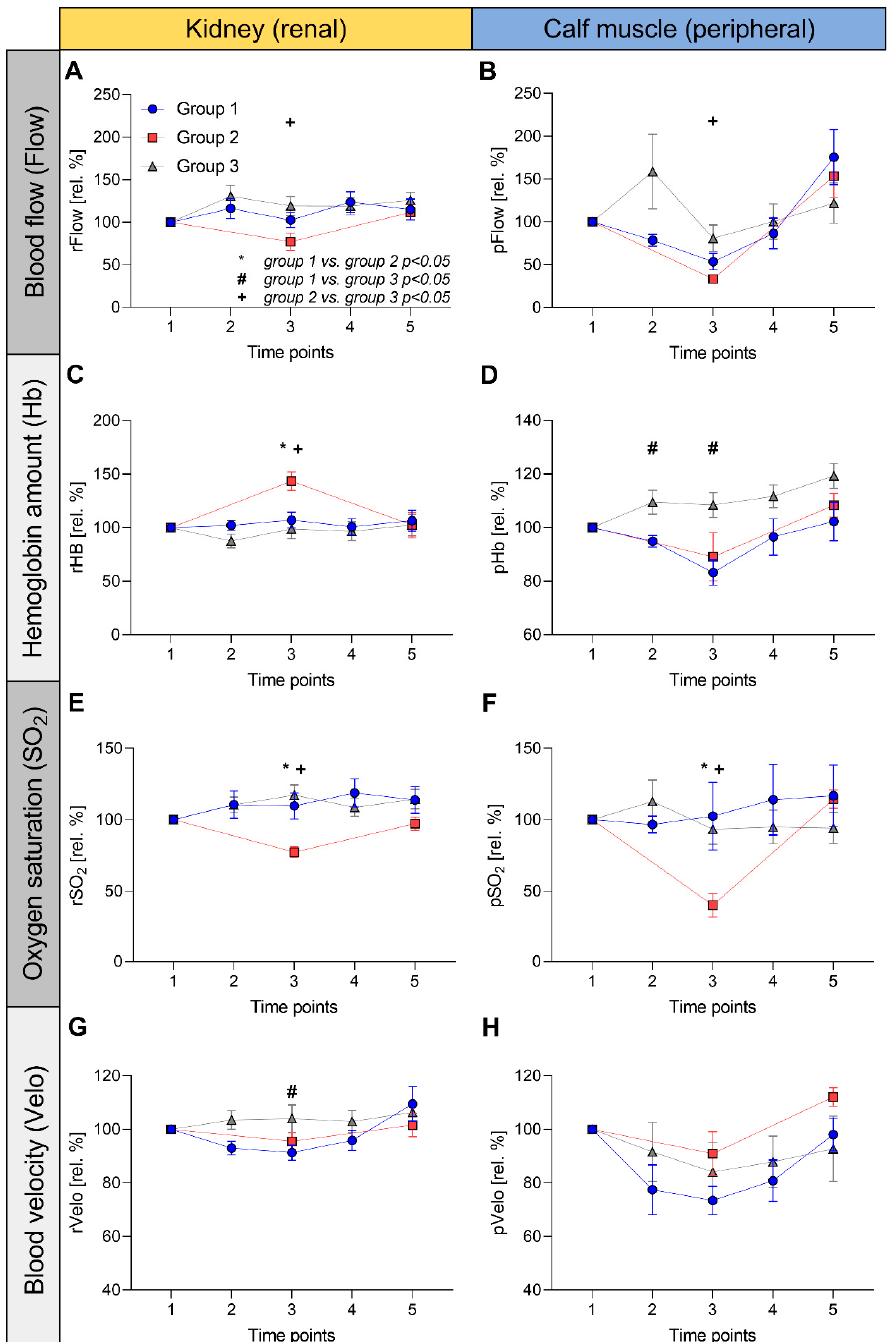
Figure 2. Intraoperative course of tissue oxygen supply parameters of the kidney and calf muscle during selective lower body perfusion. Tissue oxygen supply is assessed noninvasively using the O2C device and yielded blood flow (Flow, ( A , B )), hemoglobin amount (Hb, ( C , D )), oxygen saturation (SO 2 , ( E , F )), blood velocity (Velo, ( G , H )) of the kidney (prefix “r” for renal, left column), and the calf muscle (prefix “p” for peripheral, right column). In each diagram, the values of the patients who underwent cardiac surgery under selective lower body perfusion (group 1), those who underwent off-pump coarctation resection (group 2), and the patients who underwent procedures under standard cardiopulmonary bypass (group 3) are given in relative percentages (rel. %), normalized to the initial values (time point 1) using symbols (mean) and antennas (standard error of the mean). Symbols reflecting statistically significant differences ( p < 0.05) between the groups: * group 1 vs. group 2, # group 1 vs. group 3, + group 2 vs. group